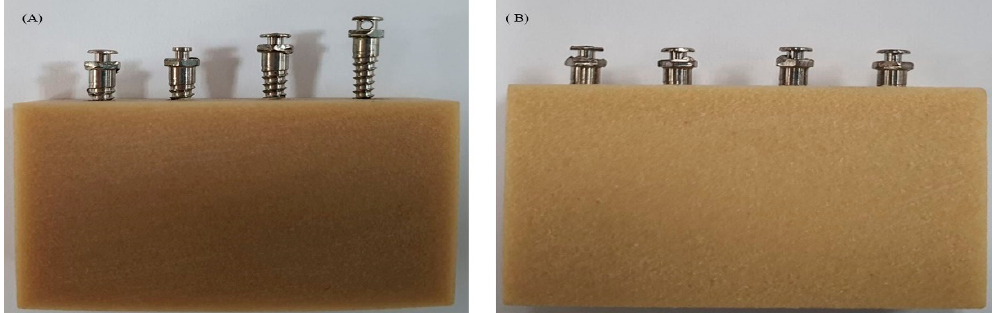
Figure 6. Insertion torque measurement. ( A ) four rotations (1440°) of OAS length, ( B ) maximum rotations of orthodontic anchor screw (OAS).